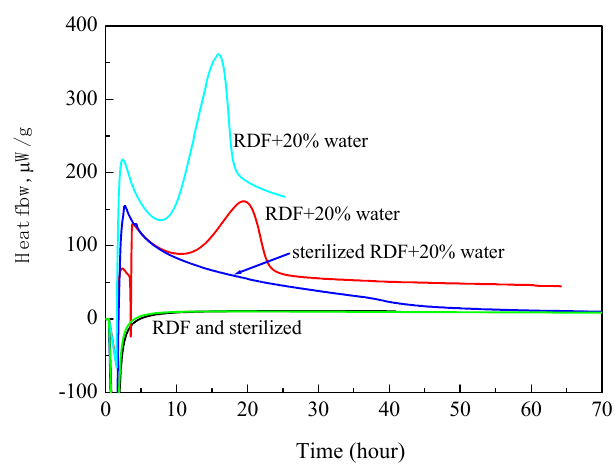
Figure 6. TAM results of RDF, at 50